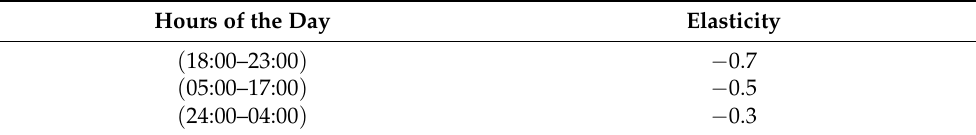
Figure 17. DR with Coincidence Factor. Table 4. Elasticity